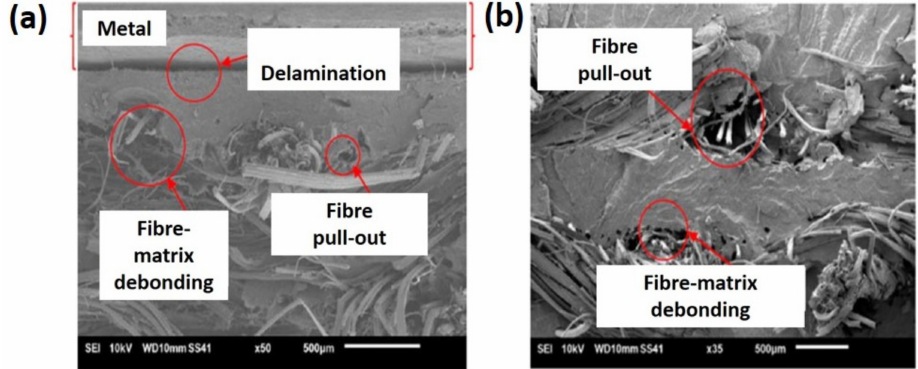
Figure 12. SEM micrograph of tensile fracture of ( a ) NFML and ( b ) NF composite. Reproduced from ref.